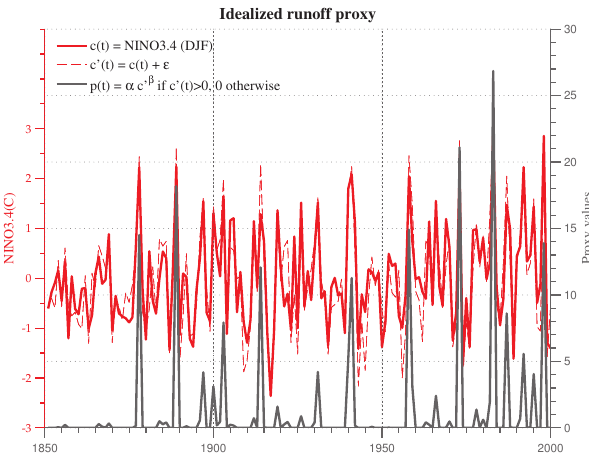
Figure 1. A nonlinear recorder of ENSO activity. Solid red: December–January–February average of the NINO3.4 index from the ERSSTv3 data set (Smith et al., 2008), standardized to Z scores; dashed red: standardized NINO3.4 with additive N (0 , 0 . 25) noise; grey: the noisy NINO3.4 signal transformed according to Eq. (1), with α = 1 and β =